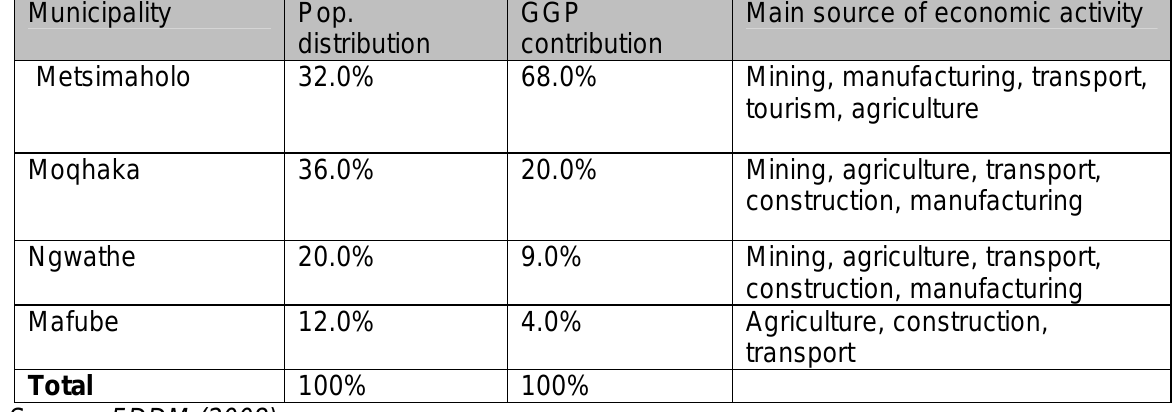
TABLE 2: Economic contribution of municipalities in FDDM Municipality Pop.